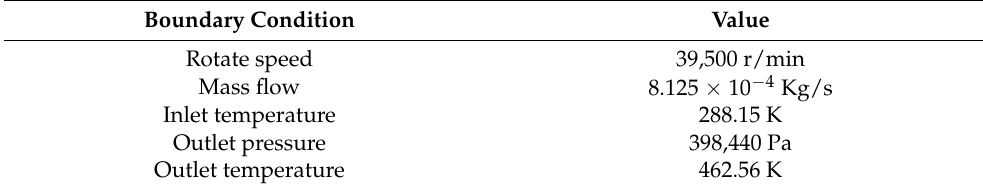
Table 1. Boundary conditions of finite element analysis. Table 2. Material properties of Ti-6AL-4 V [23].